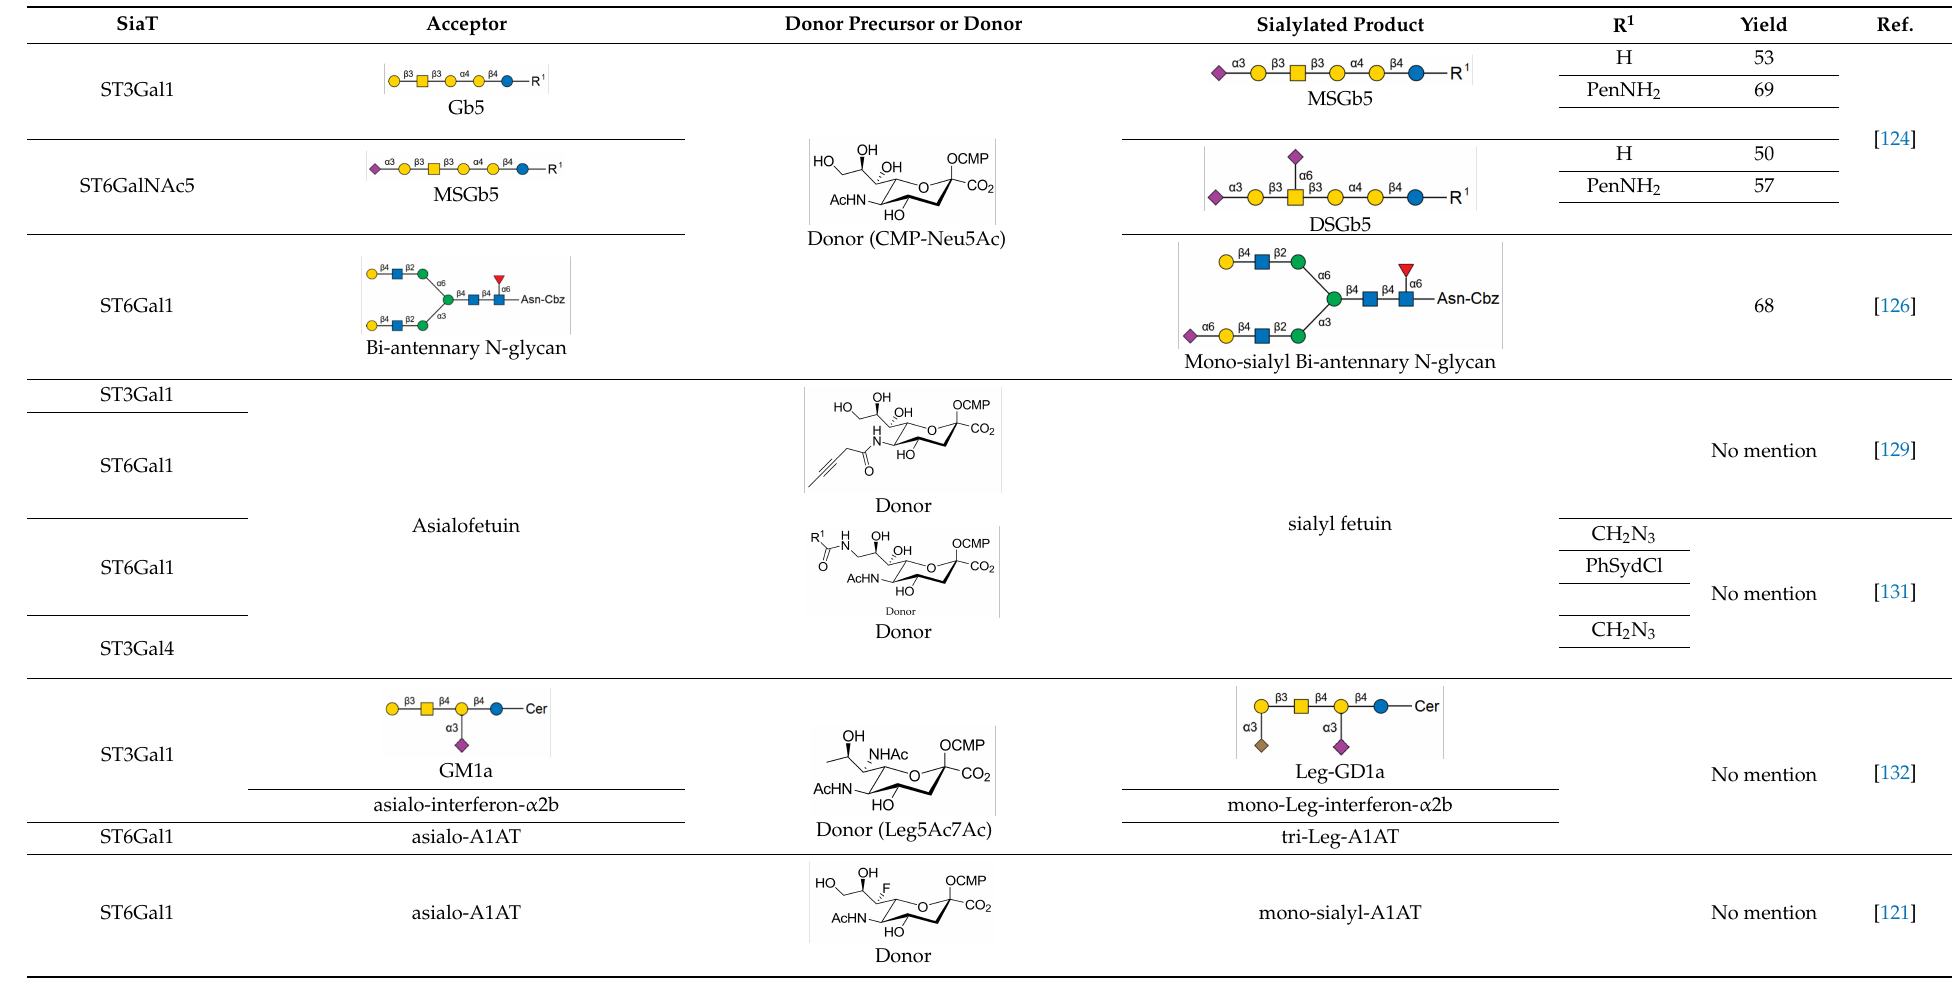
Table 3. Examples of in vitro chemoenzymatic sialylation achieved by mSiaTs. Acceptor substrates, donor substrates, sialylated products, derivatized moieties (R1), yields, and references are also listed. The abbreviations are as follows: MS, mono-sialyl; DS, di-sialyl; Pen, pentyl; Cbz, benzyloxycarbonyl; PhSydCl, 3-(4-carbamoylphenyl)-4-chlorosydnone; Cer, ceramide; A1AT, α 1-antitrypsin. (Following